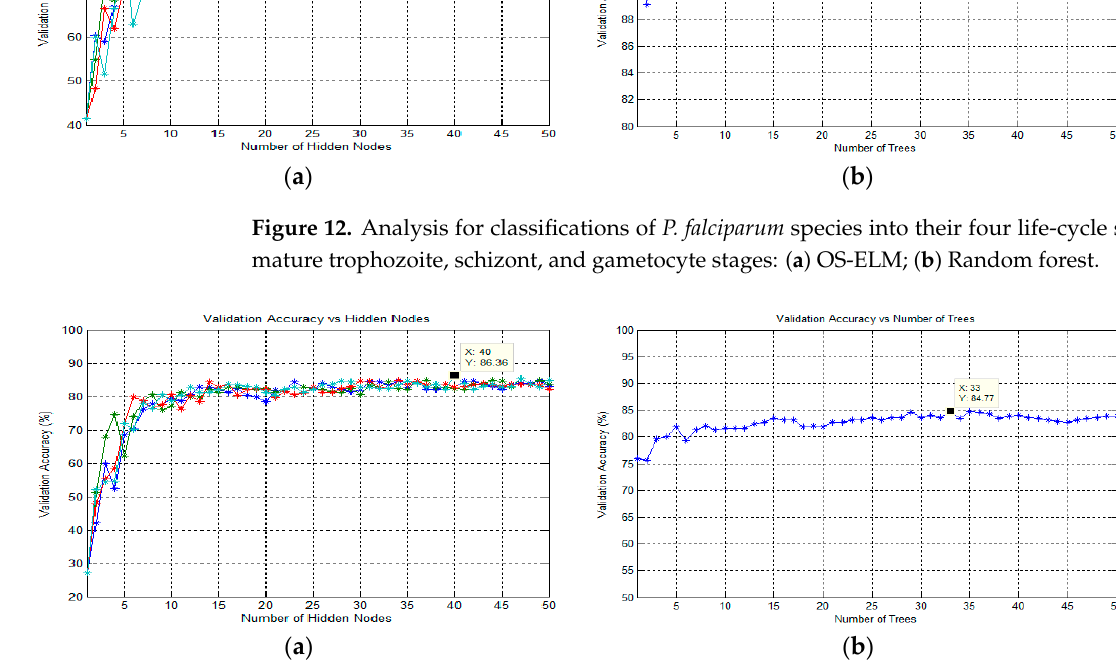
Figure 13. Analysis for classifications of P. vivax species into their four life-cycle stages: ring, mature trophozoite, schizont, and gametocyte stages: ( a ) OS-ELM; ( b ) Random forest.